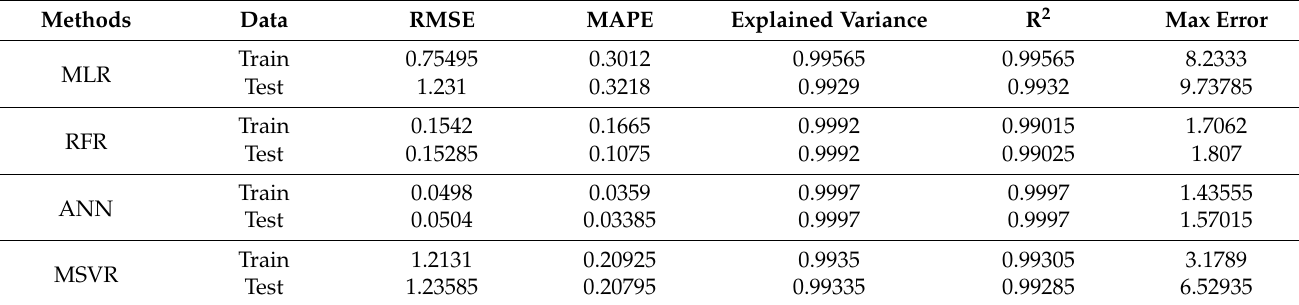
Table 1. Table with results derived from the four methods used.